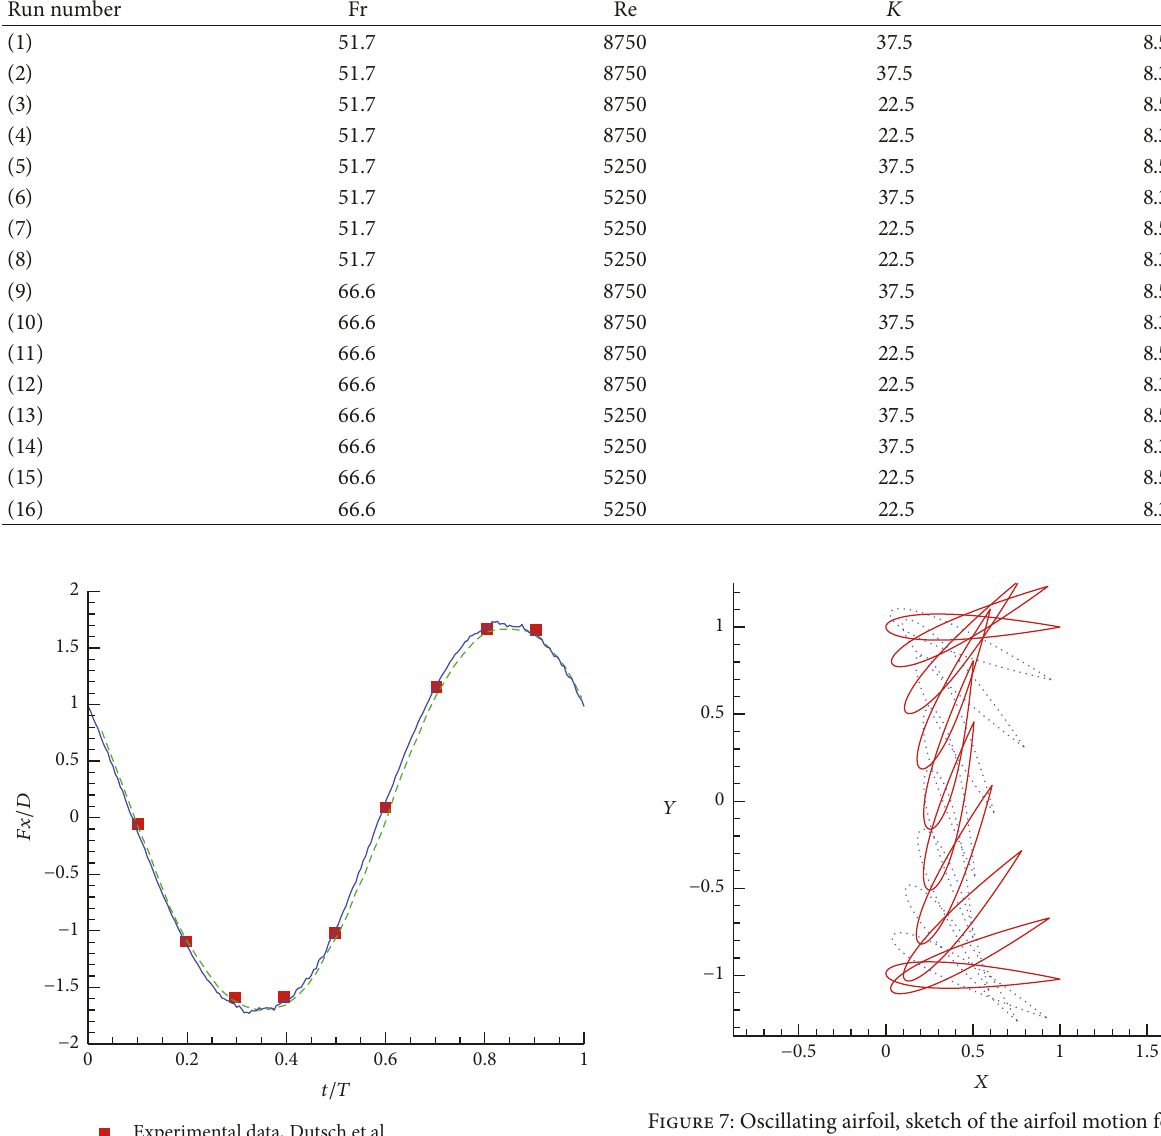
Table 1: Parameters for numerical experiments.